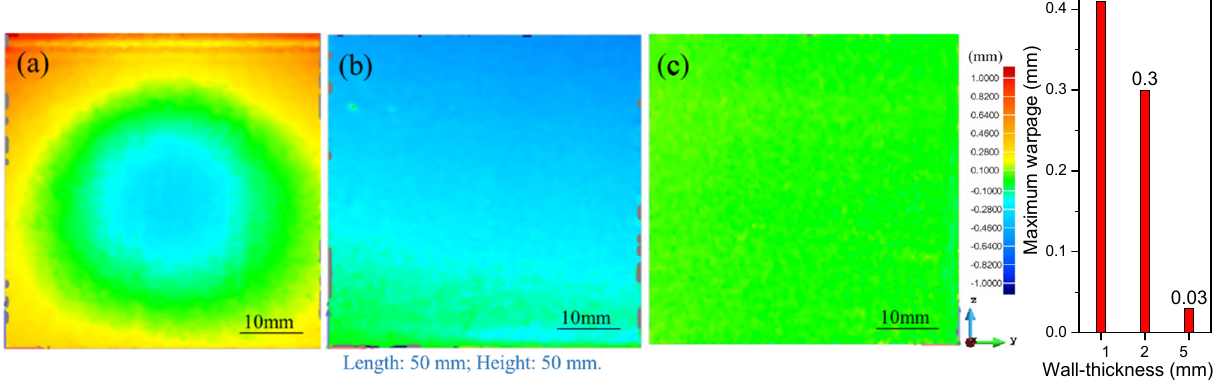
Figure 3. Residual warpage (out-of-plane displacement) for the single-wall structures for different wall-thicknesses: ( a ) 1 mm; ( b ) 2 mm; ( c ) 5 mm, respectively. ( d ) Maximum warpage recorded in the middle section.